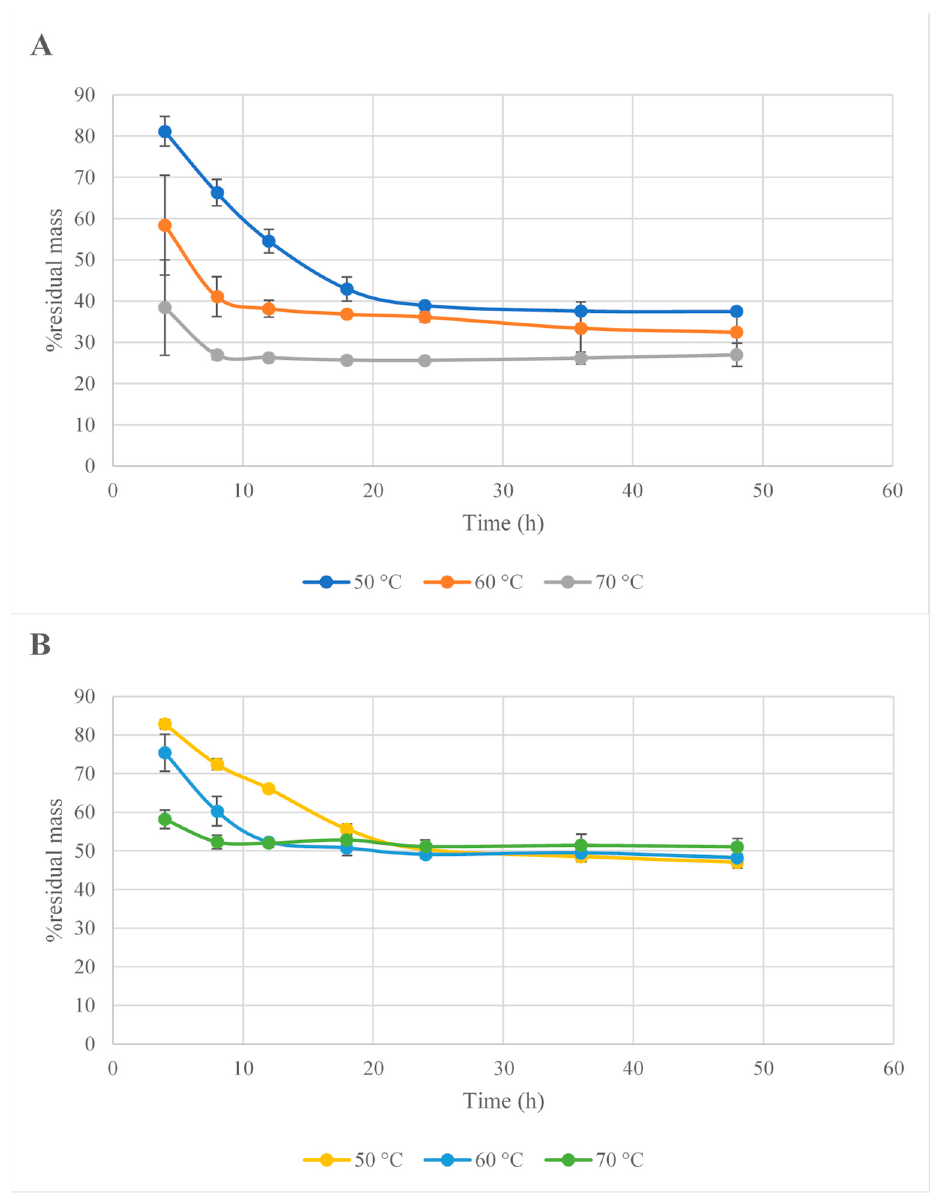
Figure 1. Residual mass percentage versus drying time for temperatures of 50, 60, and 70 °C in B. vulagris ( A ) and C. monogyna ( B ).